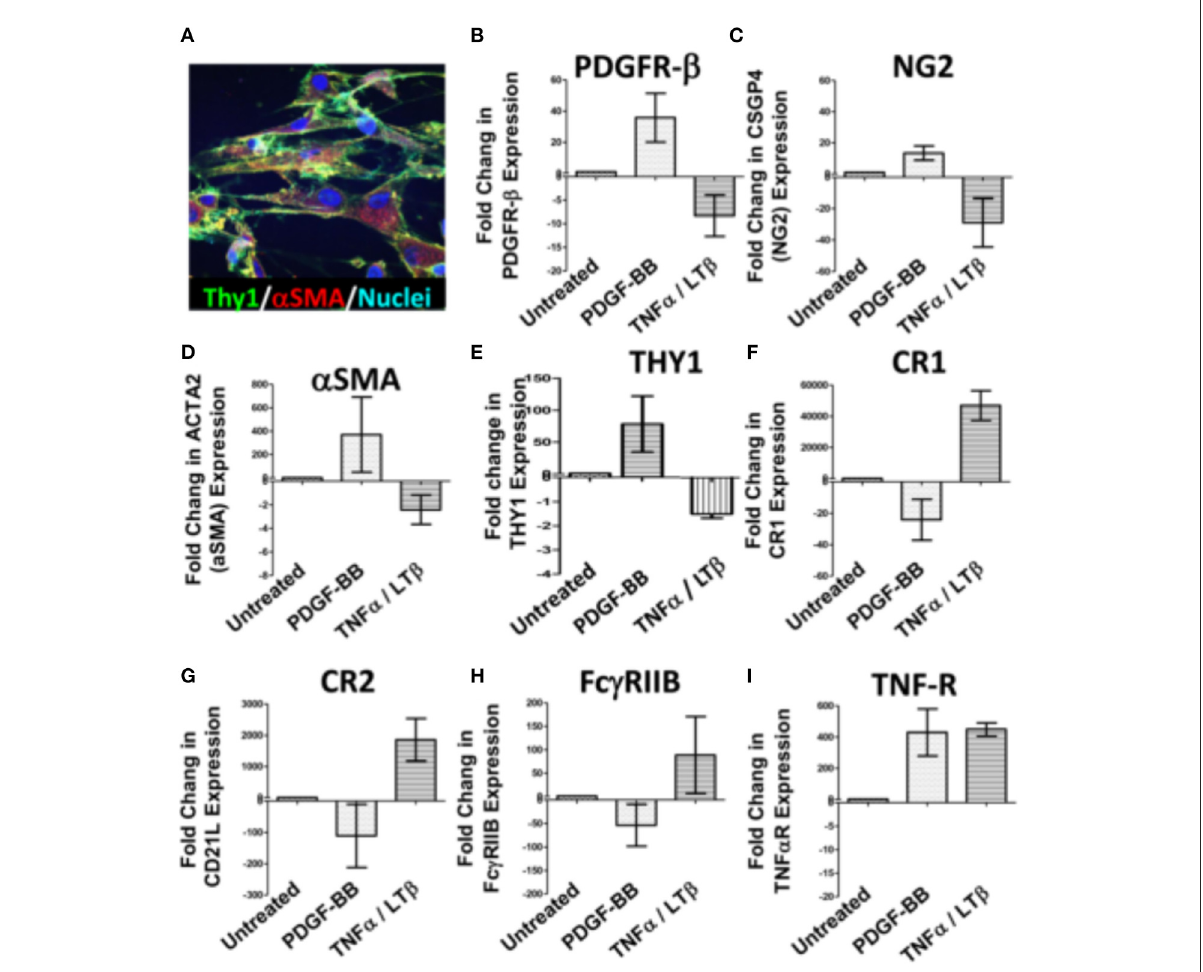
FIGURE3 Regulation of synovial stromal cell gene expression by PDGF-BB and TNF α /LT β . RA synovial stromal cells expressing Thy-1 on the cell membrane and displaying intracellular α SMA labeling (A) were treated with 300ng/ml PDGF-BB or 100ng/ml TNF- α + 100ng/ml LT- αβ and the fold change in gene expression compared to untreated cells was calculated by Livak’s DD equation. (B–I) Show the fold change in PDGFR- β , CSGP4 (NG2), ACTA2 ( α SMA), TNFRSF1A (TNF-R), THY1, CR1 (CD35), CR2 (CD21L), Fc γ RIIB (CD32), and TNF- α R, respectively. Error bars represent the SEM of three different cell